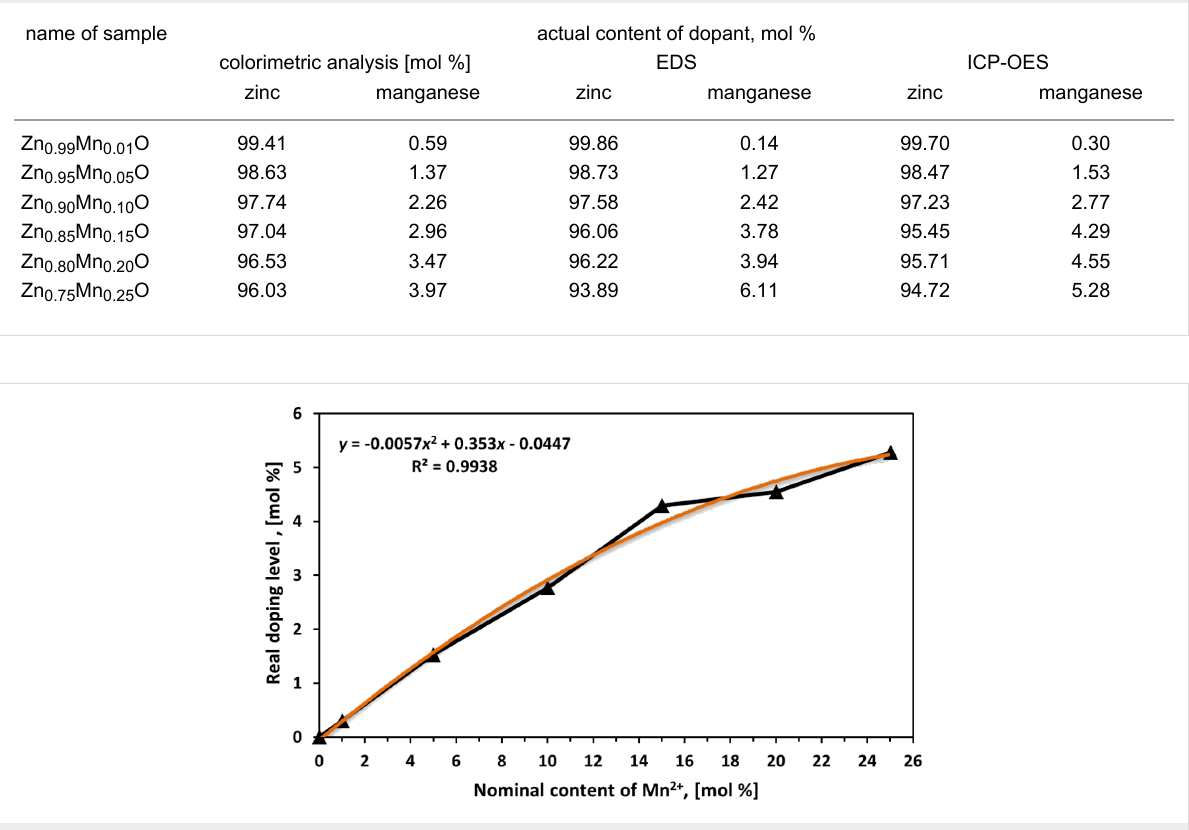
Table 4: Analysis of chemical composition of Zn 1 − x Mn x O samples.